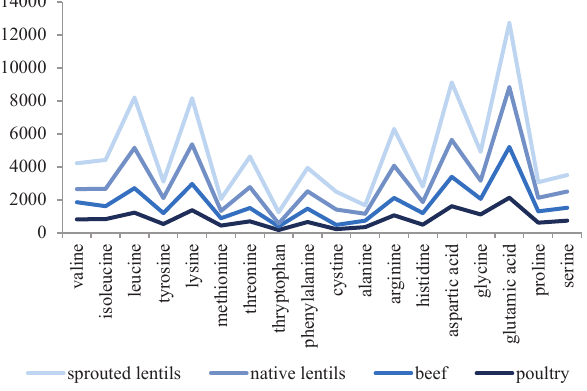
Figure 1 Amino acid composition of lentil grains, beef and poultry